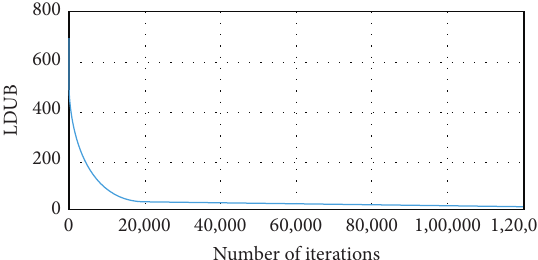
Figure 6: Evolution of average LDUB in function of iterations.